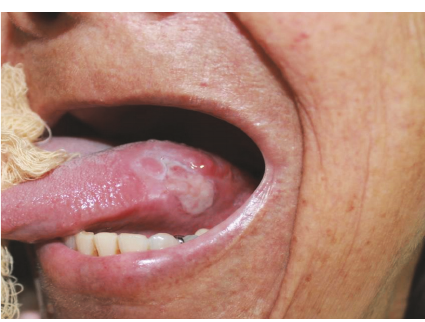
Figure 9: Postoperative week 6.